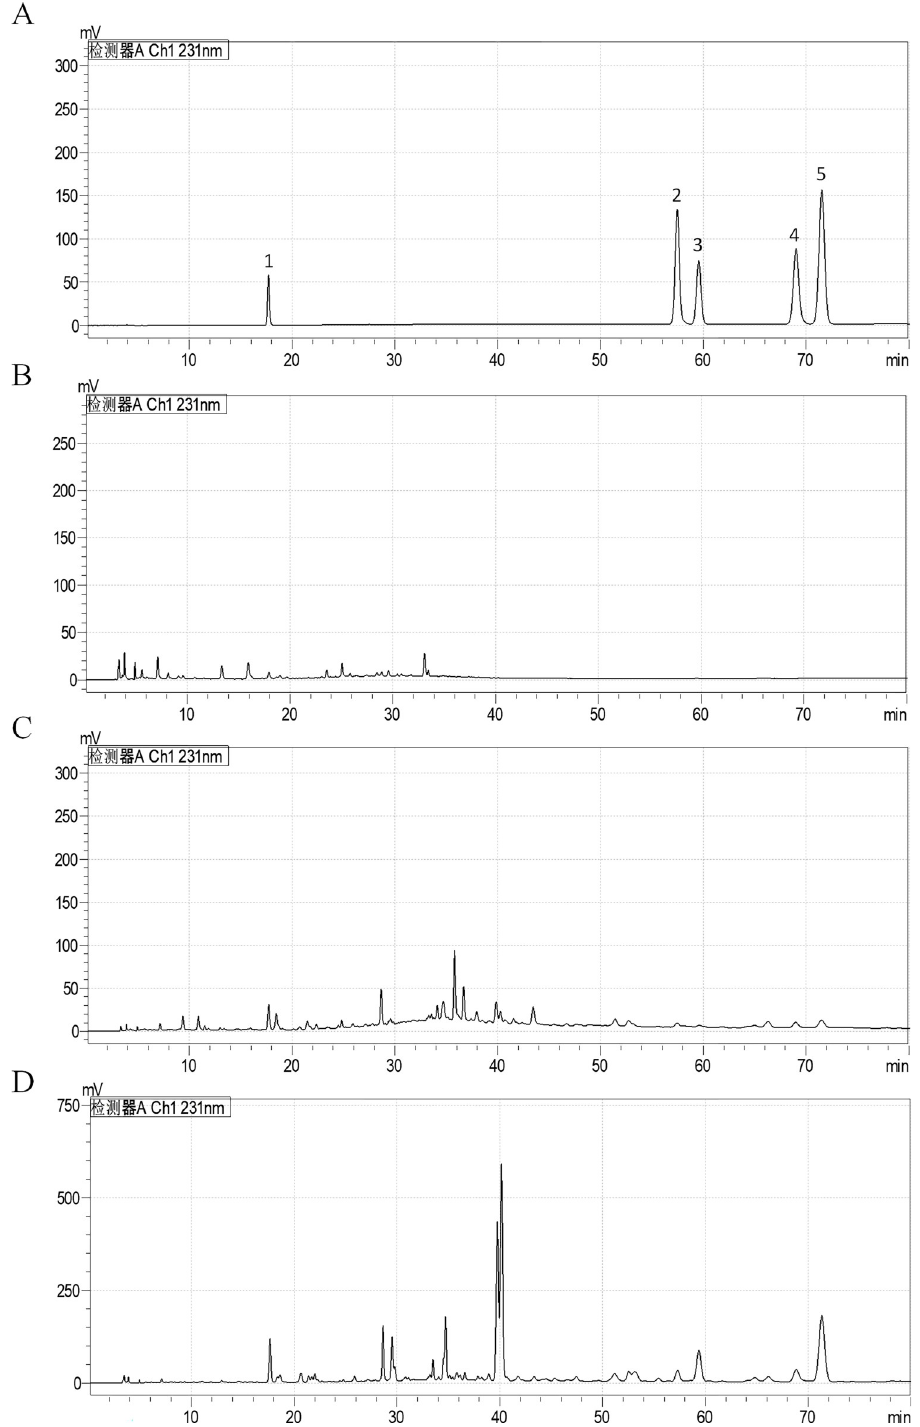
Fig 7. HPLC chromatograms of five chromones in the brown zone (B), wild agarwood (W), and healthy zone (H). The standard mixtures of (1) AH1, (2) N, (3) AH3, (4) AH8, and (5) AH6 are shown in (A). The presence of these chromones in H, B, and W are shown in